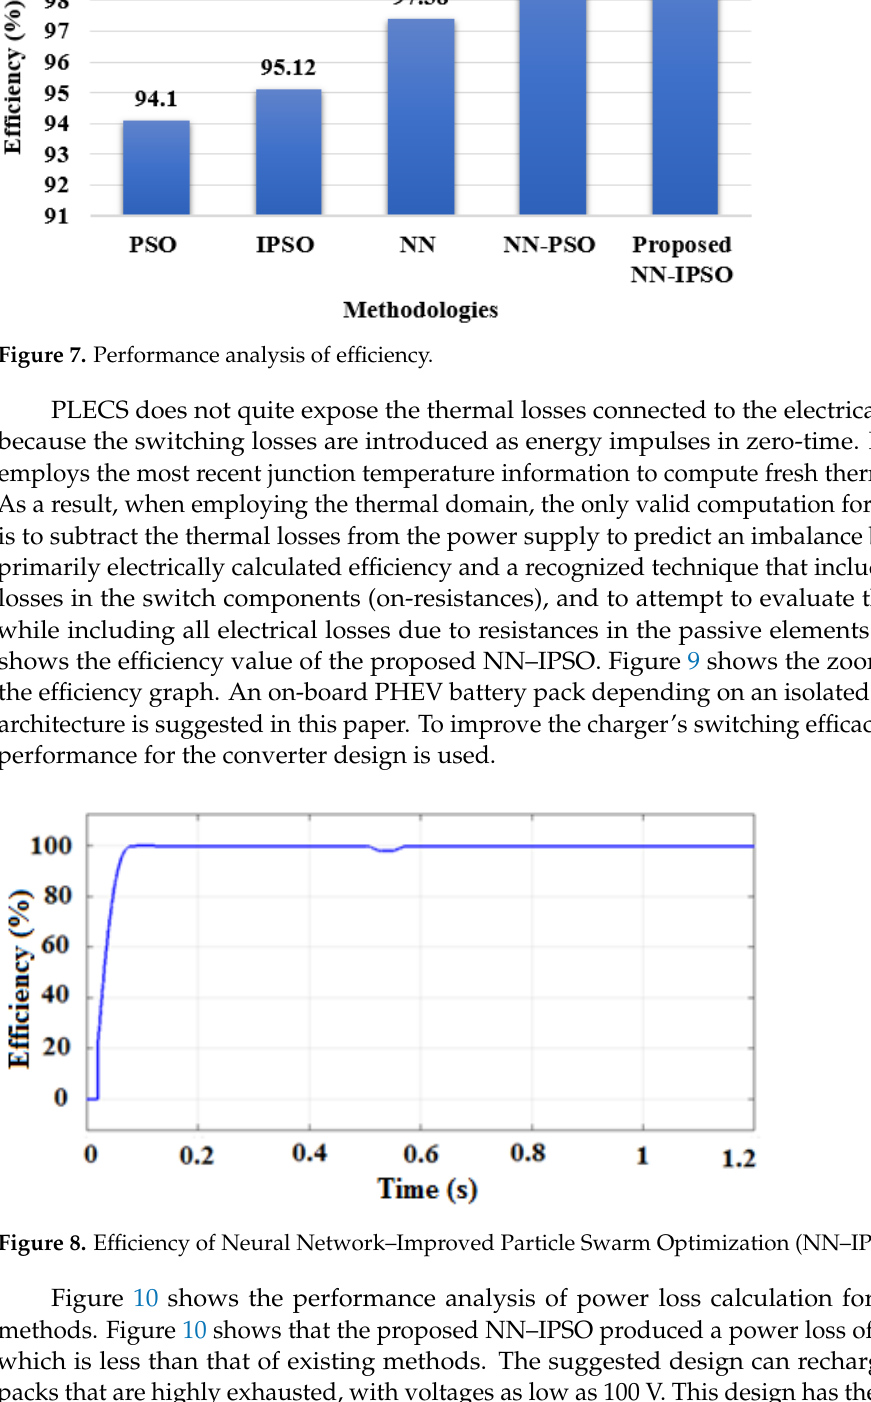
Figure 9. Zoom view of efficiency. Figure 10 shows the performance analysis of power loss calculation for different methods. Figure 10 shows that the proposed NN – IPSO produced a power loss of 0.083 kW, which is less than that of existing methods. The suggested design can recharge battery packs that are highly exhausted, with voltages as low as 100 V. This design has the poten- tial to raise and lower the input voltage that can be used in the front-end power conversion phase. In PFC applications, both steady-state assessment and AC small-signal modeling of the structure are removed. The CCM procedure is confirmed using method factors, and the voltage and current fluctuations are carefully considered. The isolated converter and inverter stages of a charger are intended to validate the evidence of perception. The com- putational results show that the suggested charger can support a wide voltage range while keeping the converter functioning at the preferred efficiency level.